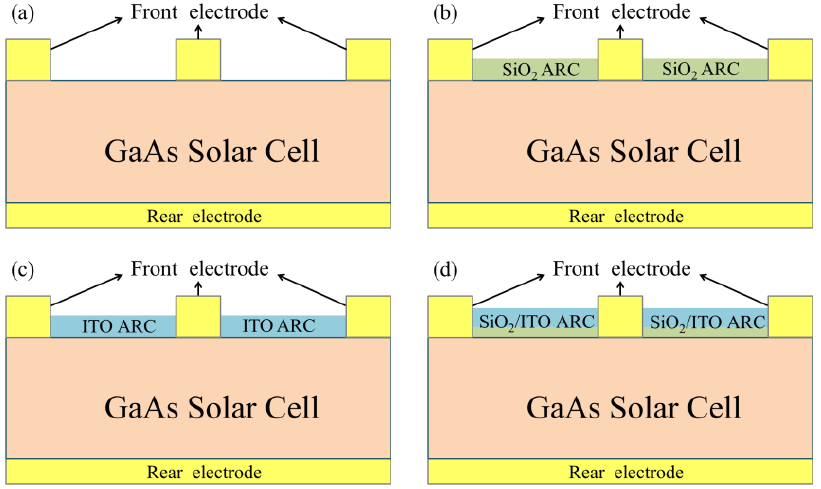
Figure 2. Schematic diagram showing ( a ) single-junction GaAs bare solar cell; ( b ) GaAs cell with SiO 2 AR-coating (ARC); ( c ) GaAs cell with indium tin oxide (ITO) ARC; ( d ) GaAs cell with thin-SiO 2 /ITO ARC.